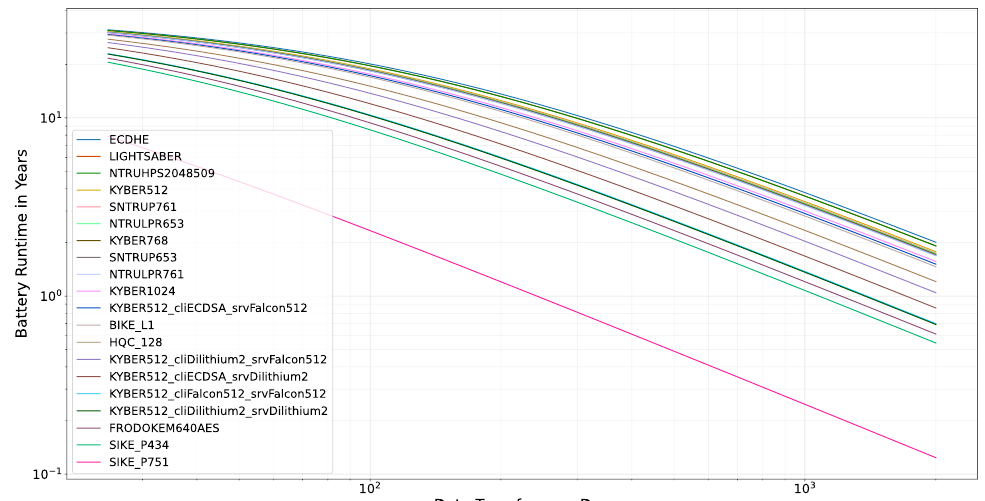
Figure 12. Battery runtime estimations for different